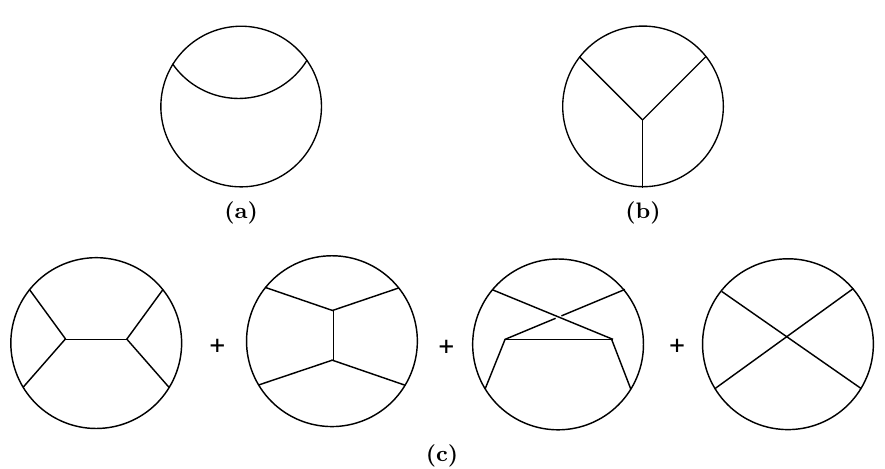
Figure 14. The Witten diagrams for the AdS computation of CFT correlation functions of O . The (a) two-point function (b) three-point function and (c) four-point